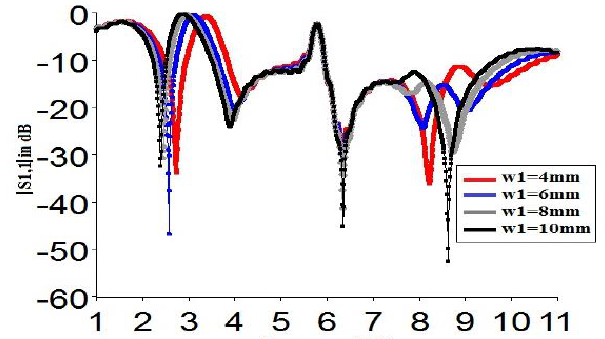
Figure 3: Simulated S 11 parameters of the proposed antenna with different structures.